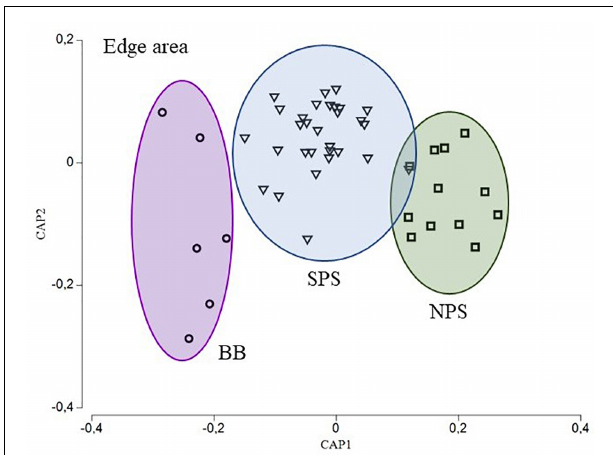
FIGURE 5 | CAP ordination diagram for C. trigloides based on the otolith chemical composition (Ba:Ca, Mg:Ca, Mn:Ca, and Sr:Ca) for the otolith edge area. Geographical areas: northern Patagonia shelf (NPS, squares), southern Patagonia shelf (SPS, triangles), and Burdwood Bank (BB, circles).